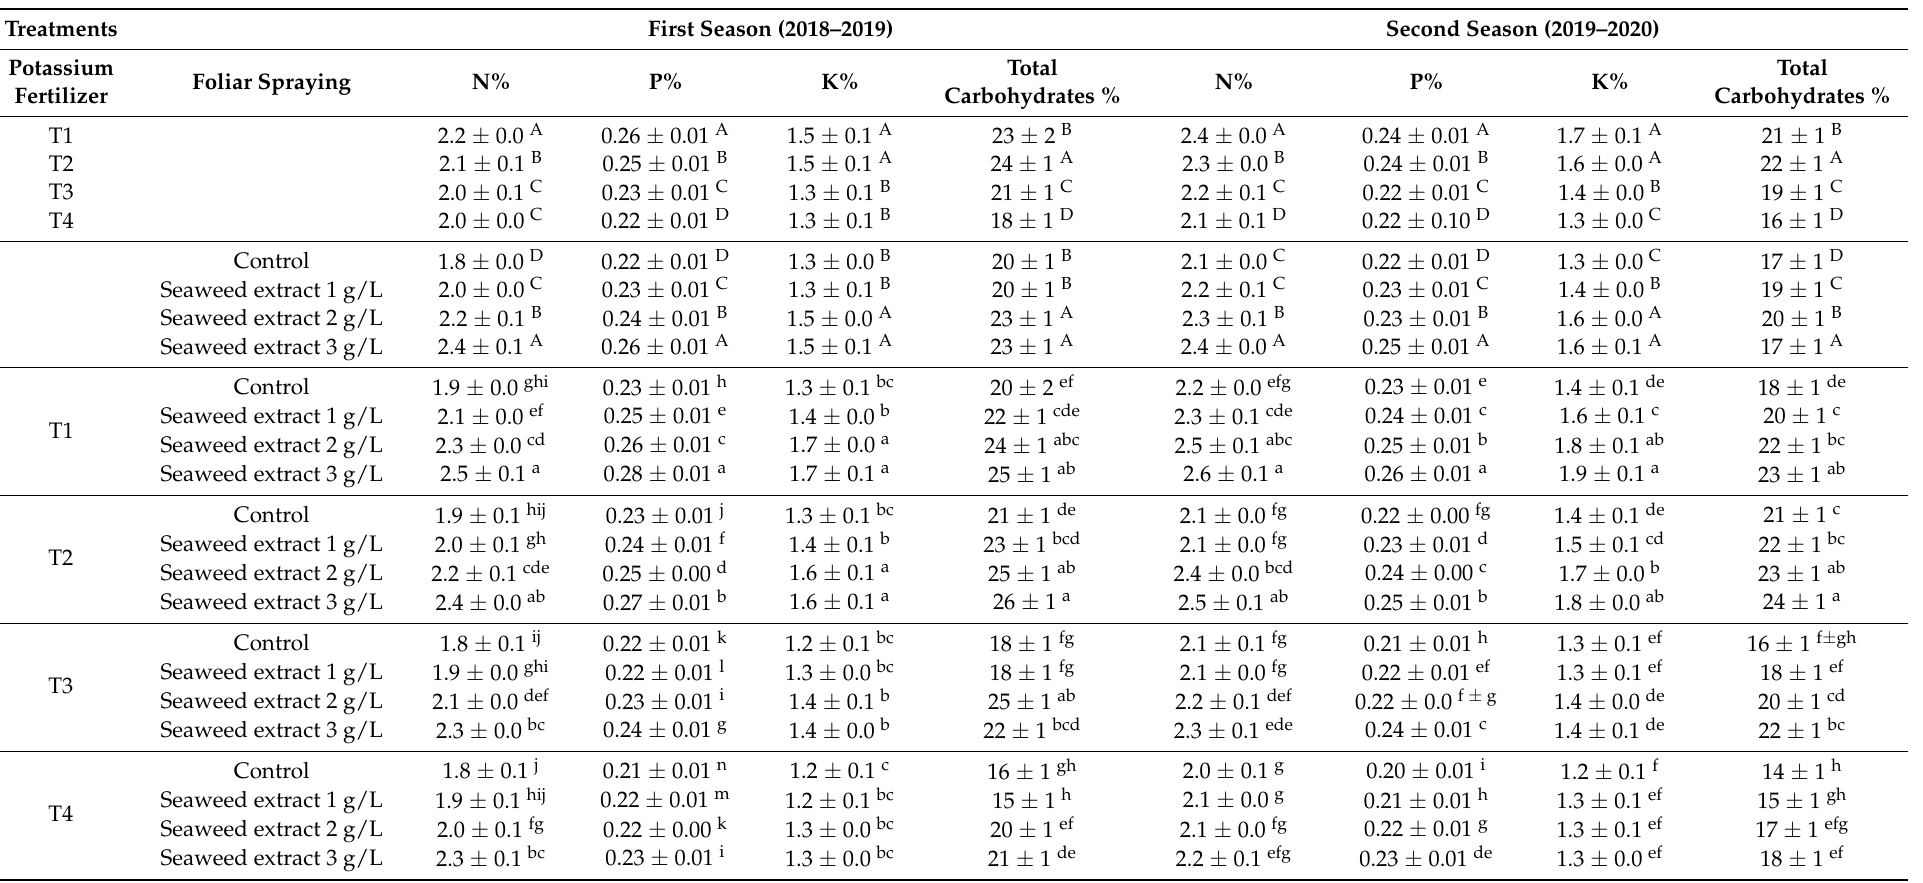
Table 5. The effect of potassium fertilizer, biofertilizer, and foliar spraying of seaweed extract on chemical composition of globe artichoke leaves.